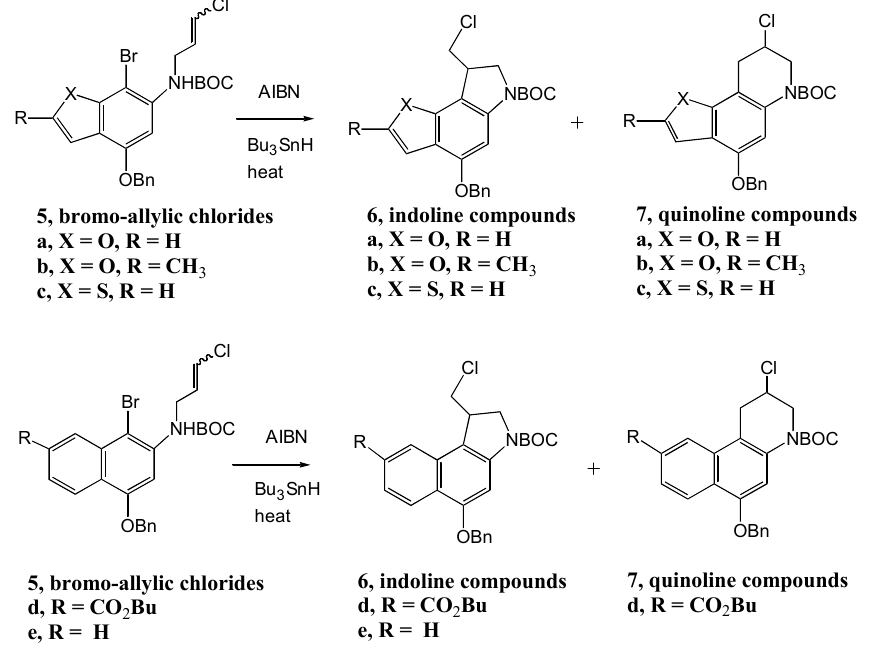
Figure 3. Free radical promoted cyclization of bromo-allylic chlorides 5a-e